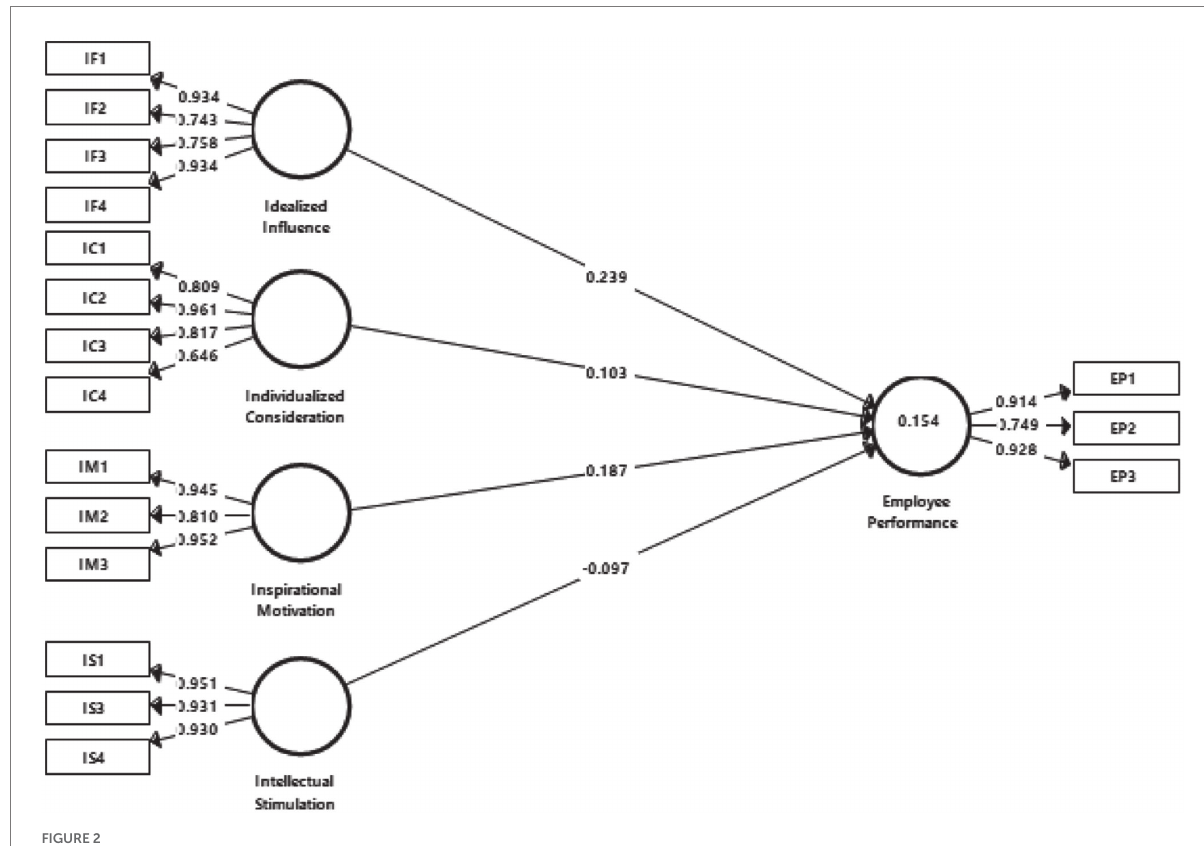
FIGURE 2 Results of assessment of structural